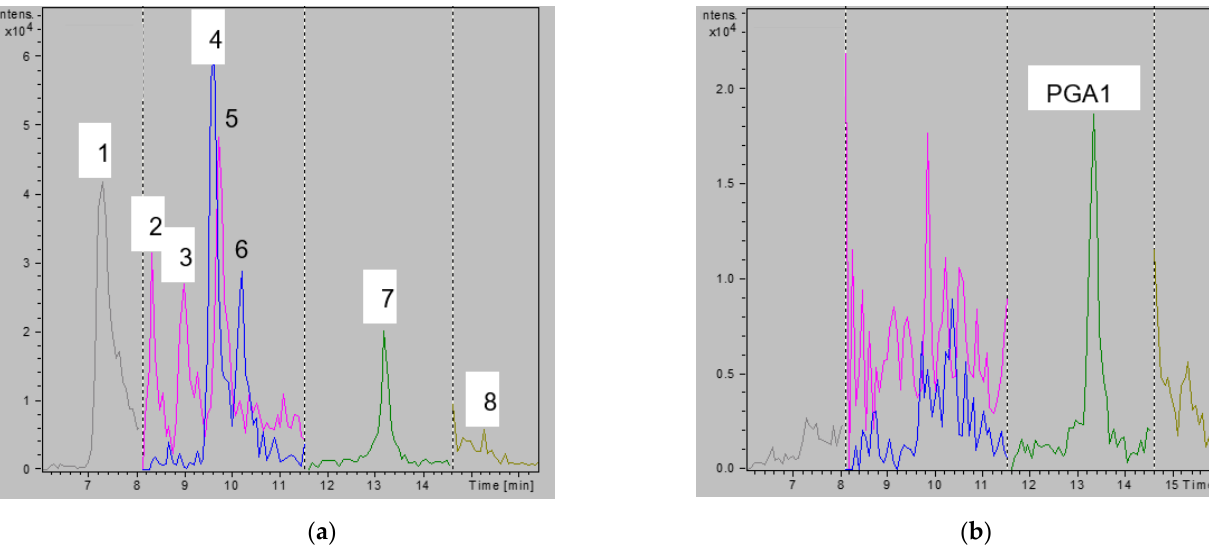
Figure 2. MRM chromatogram of reconstituted fractions after loading a PG mixture on MIP and after washing with CHCl 3 ( a ) and DCM ( b ). While in ( a ) peaks corresponding to eluted compounds are present at significant intensity values, in ( b ) the same peaks are either not present or are showing a much lower intensity. Peaks were labelled as 1 = 6kPGF 1a ; 2 = 8iPGF 2a ; 3 = PGF 2a ; 4 = PGE 2 ; 5 = PGE 1 ; 6 = PGD 2 ; 7 = PGA 1 ; 8 = 15dPGJ 2 . Colors indicate the different MRM transitions